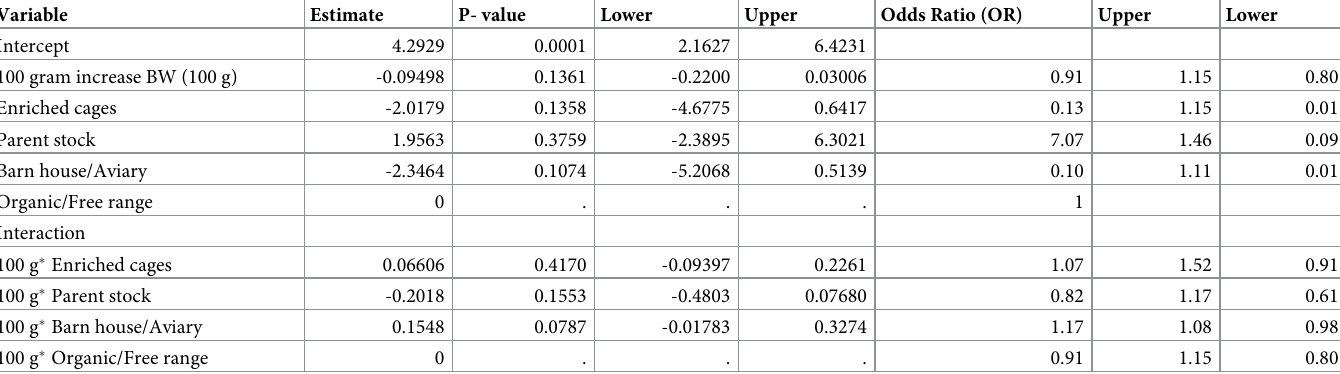
Table 12. Overview of the effects of body weight (BW) and the interaction of BW and production system on the probability of having KBF. Results from the general- ized, linear mixed model.